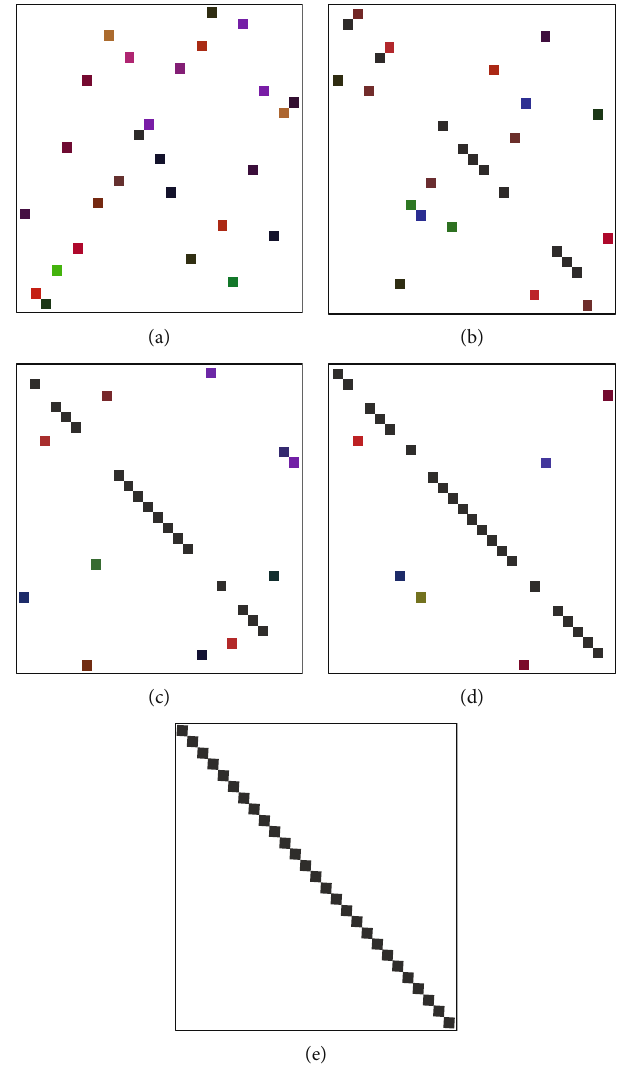
Figure 10: Example of solving 3 × 3 × 3 cube presented in block matrix notation for GA iteration: 0 (a), 4 (b), 8 (c), 12 (d), and 16 (e). Table 3: Number of used genetic algorithms with 100